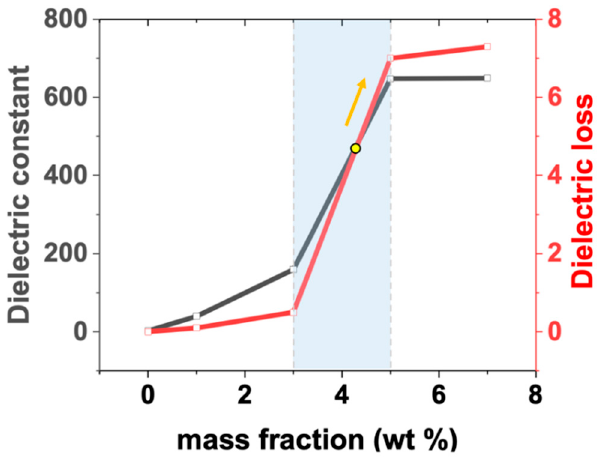
Figure 3. The dielectric constant and dielectric loss of CNT/PDMS composites as a function of mass fraction (wt%). The arrow indicates the reversed section.